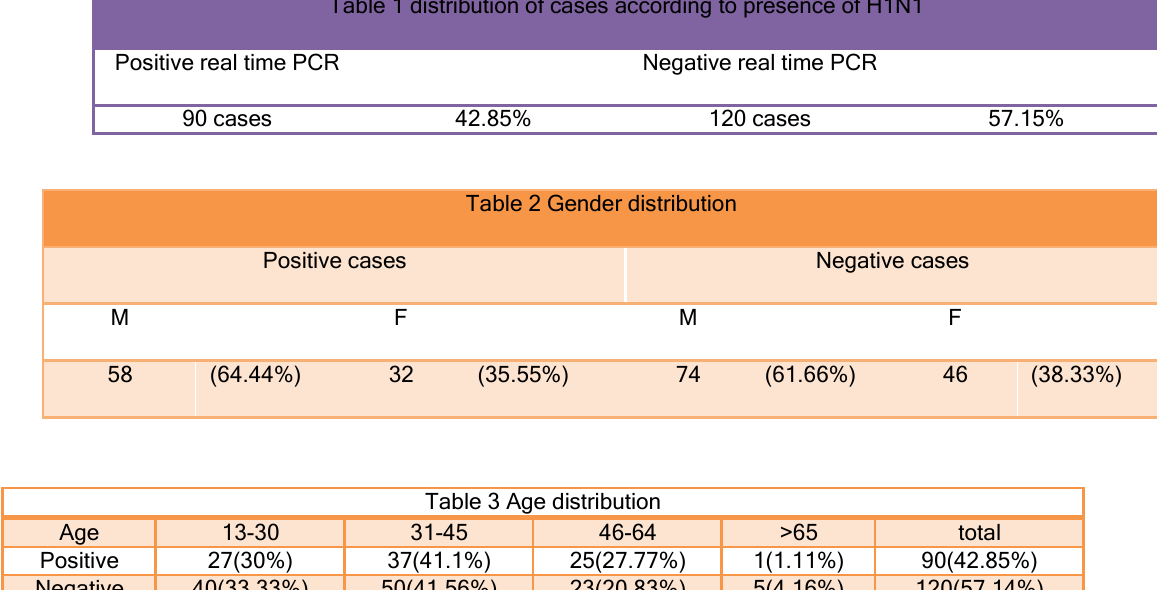
Table 1 distribution of cases according to presence of H1N1